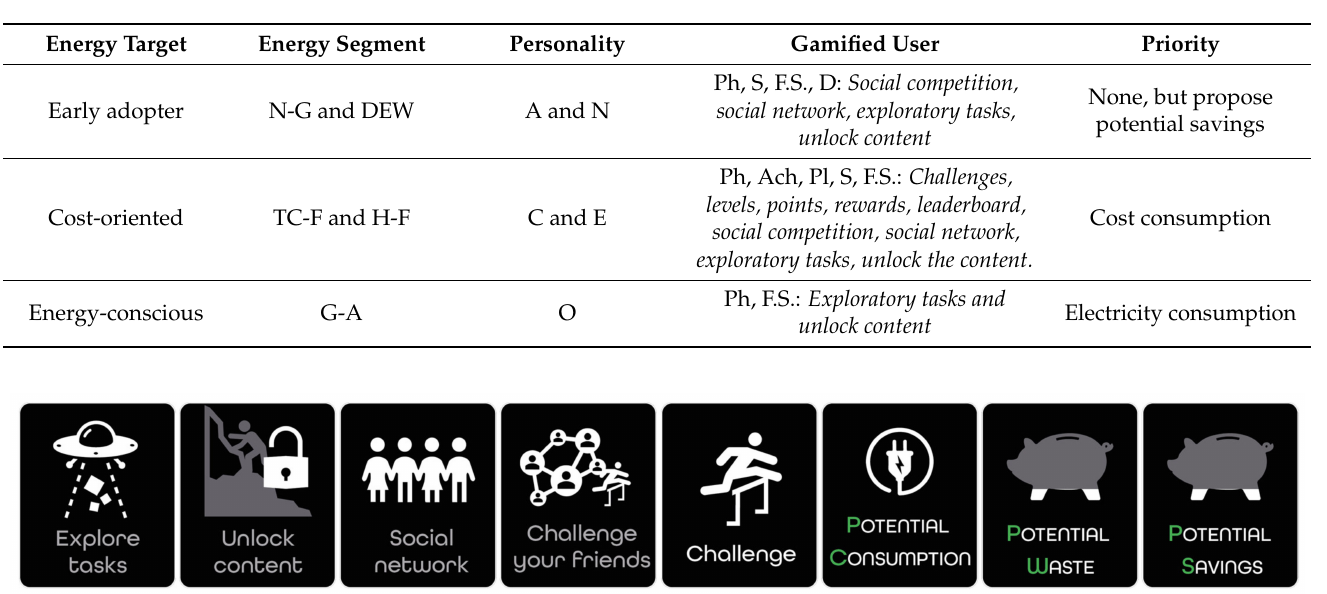
Table 1. Elements considered for the gamified HMI.